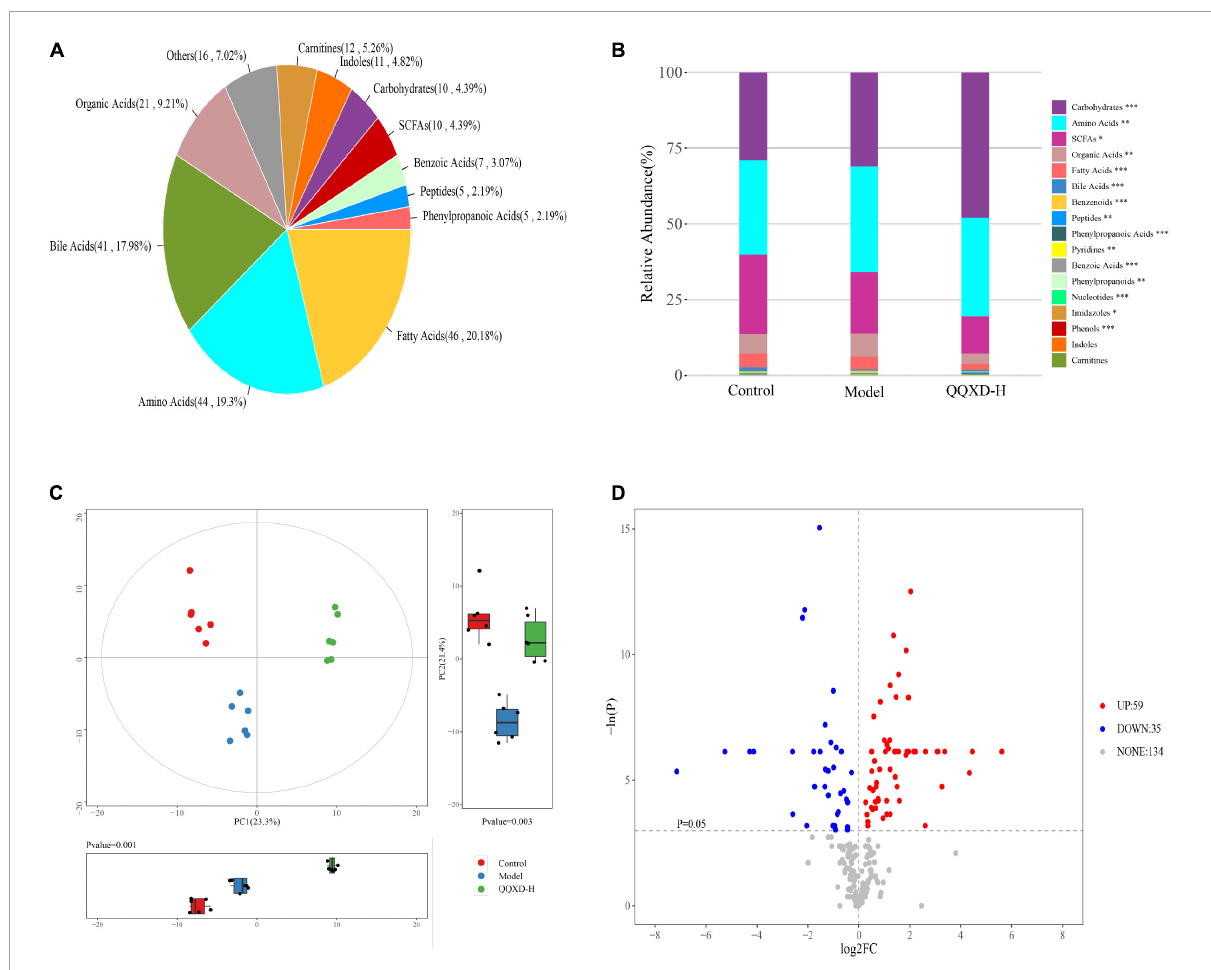
FIGURE6 Metabolite composition, component analysis and inter-group differential metabolism. (A) Statistical pie chart of category and constituent ratio of metabolites. (B) Statistical stacked histogram of relative abundance of median values of three groups of various metabolites. (C) Three groups of PCA score diagram and corresponding principal component box diagram. (D) Comparison between QQXD and Model single dimensional metabolite volcano map. Threshold setting p < 0.05 and | log2fc | ≥ 0 (FC, fold